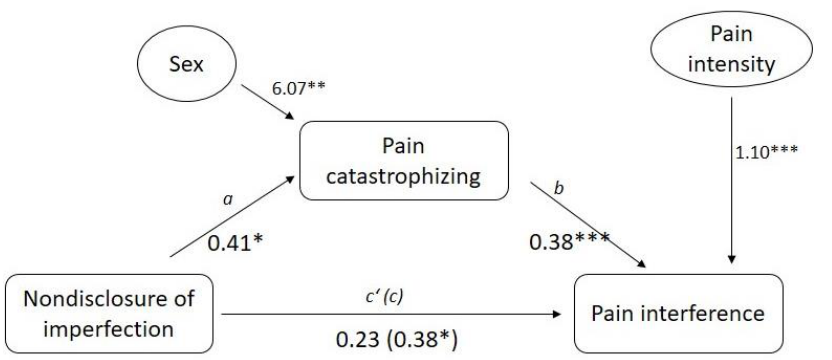
Figure 4. Mediation effect of pain catastrophizing on the association between nondisclosure of imperfection and pain interference. Note: * p < 0.05, ** p < 0.01, *** p < 0.001.